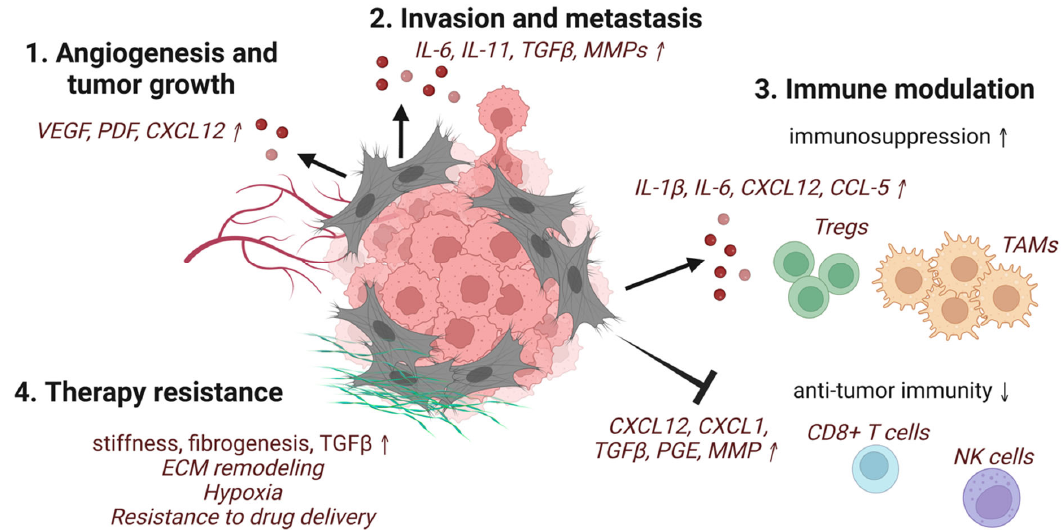
Figure 1. Schematic representation of selected pro ‐ tumorigenic functions of CAFs. CAFs induce ( 1 ) angiogenesis and tumor growth, ( 2 ) invasion and metastasis of cancer cells, ( 3 ) modulation of the immune system, including recruitment and activation of immune suppressors and inhibition of anti ‐ tumor effector cells, and ( 4 ) therapy ‐ resistance through ECM production and remodeling (created with BioRender.com accessed 19 June 2022).